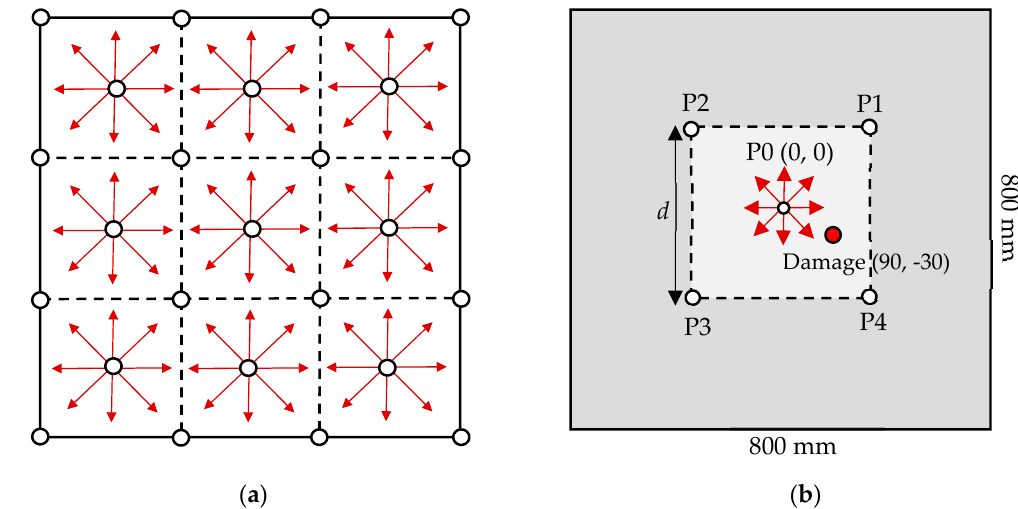
Figure 6. ( a ) A network of PZT transducers embedded in a large structure. ( b ) A single damaged cell.